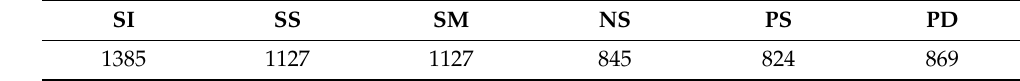
Table 2. Related image number for each group.